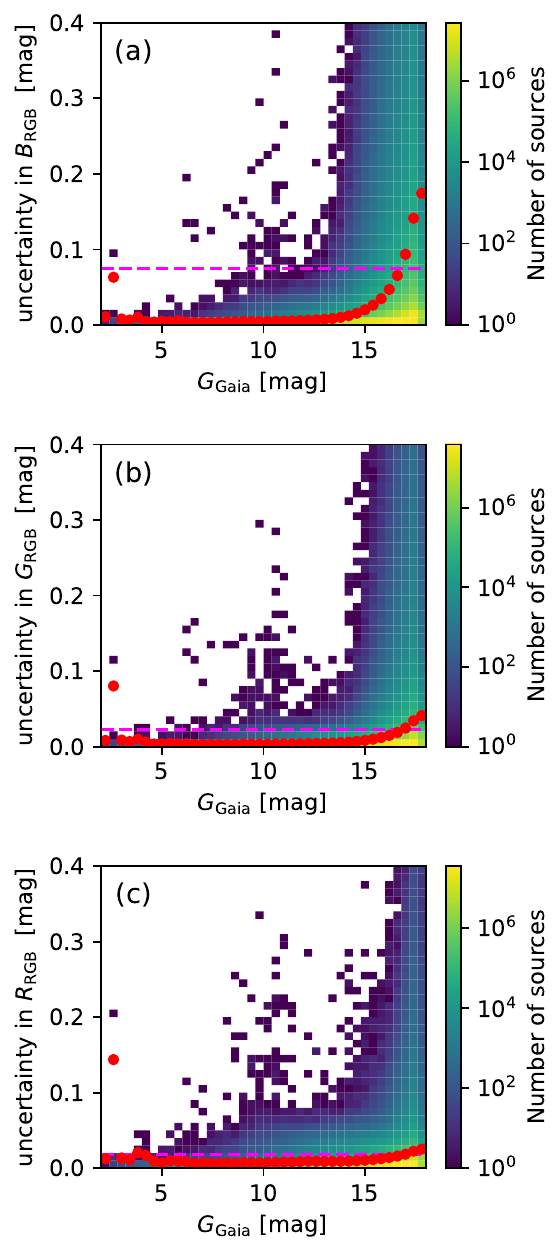
Figure 11. 2D histograms showing the number of sources as a function of G Gaia (the horizontal axis; using 0.4 mag bins) and the uncertainties in the synthetic B RGB (panel ( a )), G RGB (panel ( b )) and R RGB (panel ( c )) magnitudes (vertical axis; using 0.01 mag bins), computed as explained in Section 2. The red filled circles indicate the 99th percentile at each bin in the horizontal axis, which reveals that, for most G Gaia bins, these numbers are below 0.01 mag in the vertical axis with the exception of one bin at the bright extreme, 2.4 ≤ G Gaia ≤ 2.8 mag and for the fainter sources beyond G Gaia (cid:39) 14 mag. The magenta dashed horizontal line indicates the 99th percentile for the whole sample with values of 0.075, 0.022 and 0.019 mag for B RGB , G RGB and R RGB ,